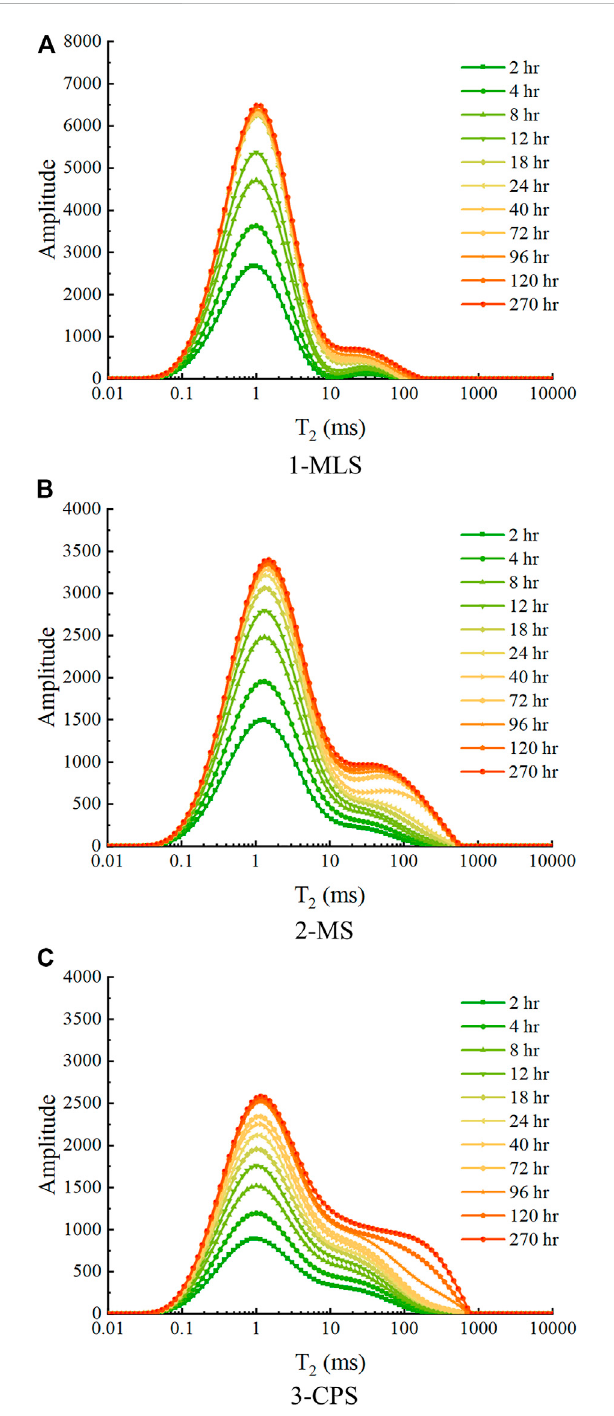
FIGURE 8 T 2 spectrums in different conditions for different cores: (A) MLS sample; (B) MS sample; (C) CPS